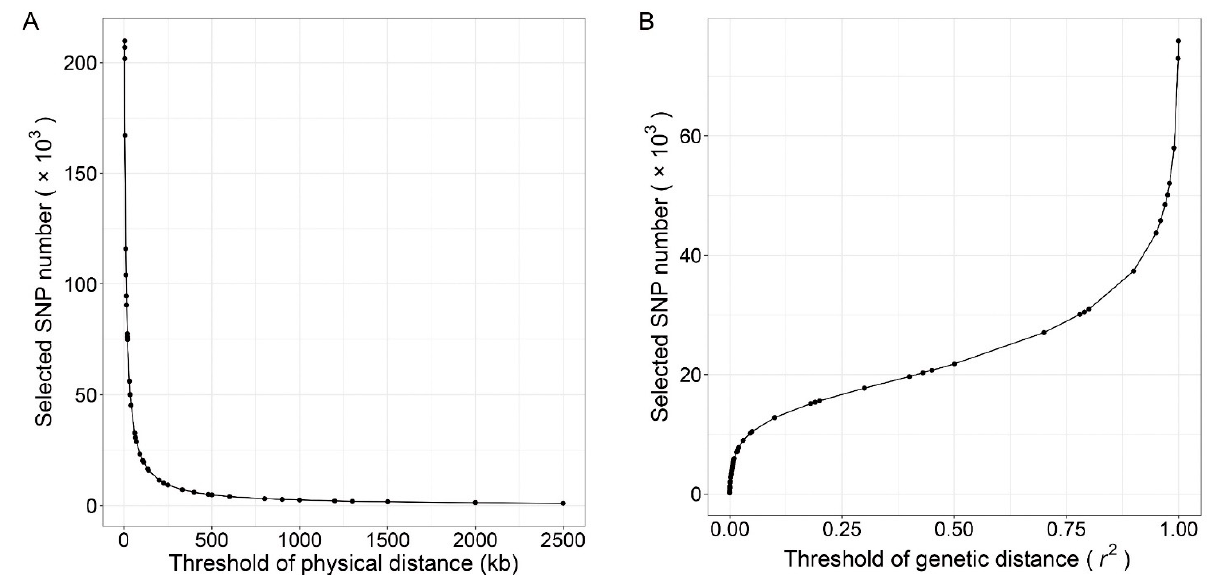
Figure 1. The relationship between the physical distance or genetic distance between adjacent SNPs and the number of SNPs selected. The number of selected SNPs against the threshold of the physical distance between adjacent SNPs is given in left ( A ), and the number of selected SNPs against the threshold of genetic distance ( r 2 ) between each pair of SNPs in the window is given in right ( B ).